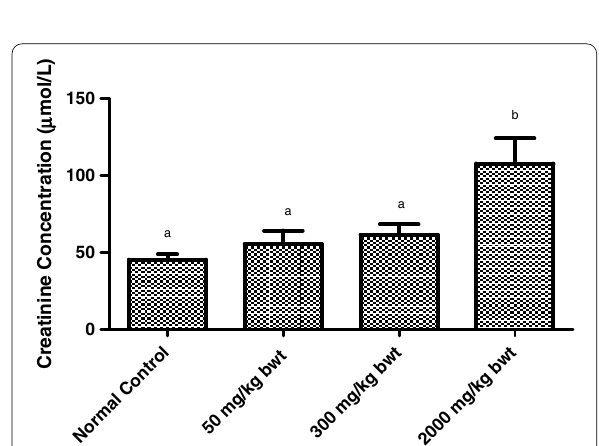
Fig. 4 Serum Creatinine Concentration in Control and Treatment Groups. Values are expressed as mean